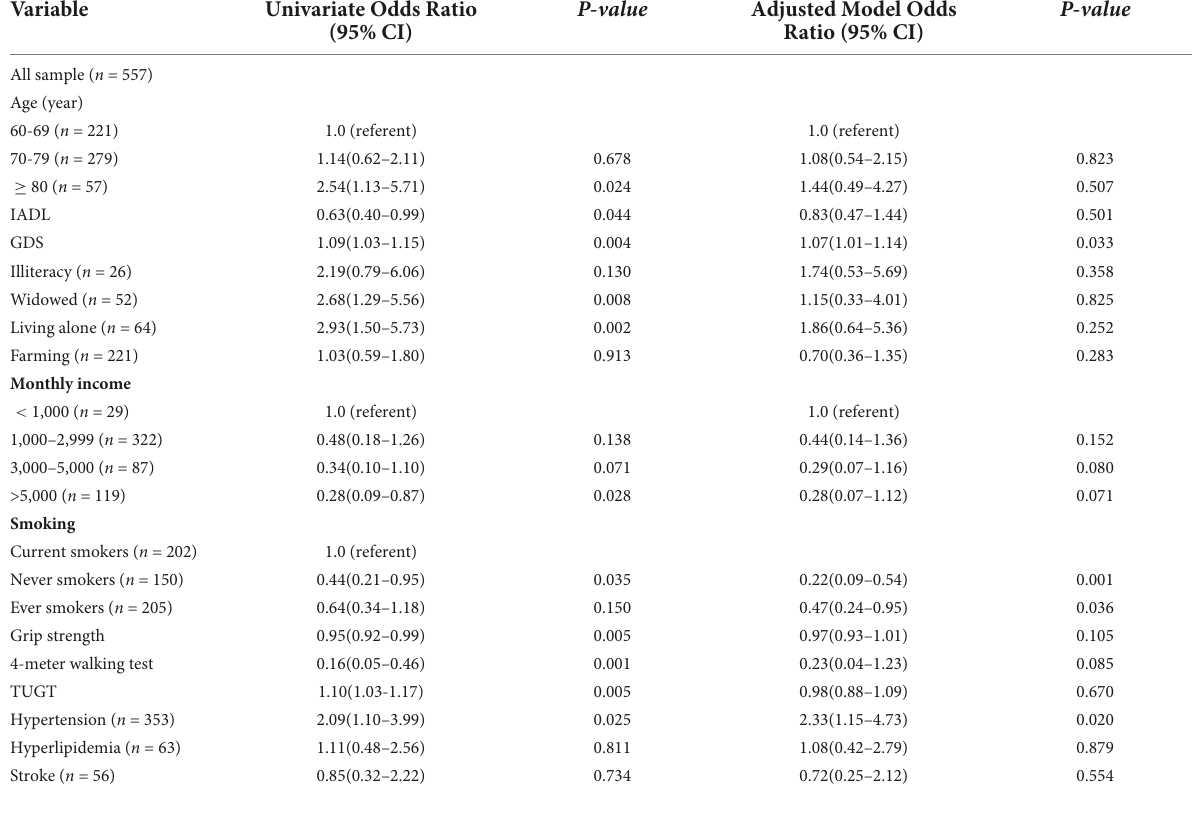
TABLE 2 Unadjusted and Adjusted Model for Factors Related to MCI in the male.